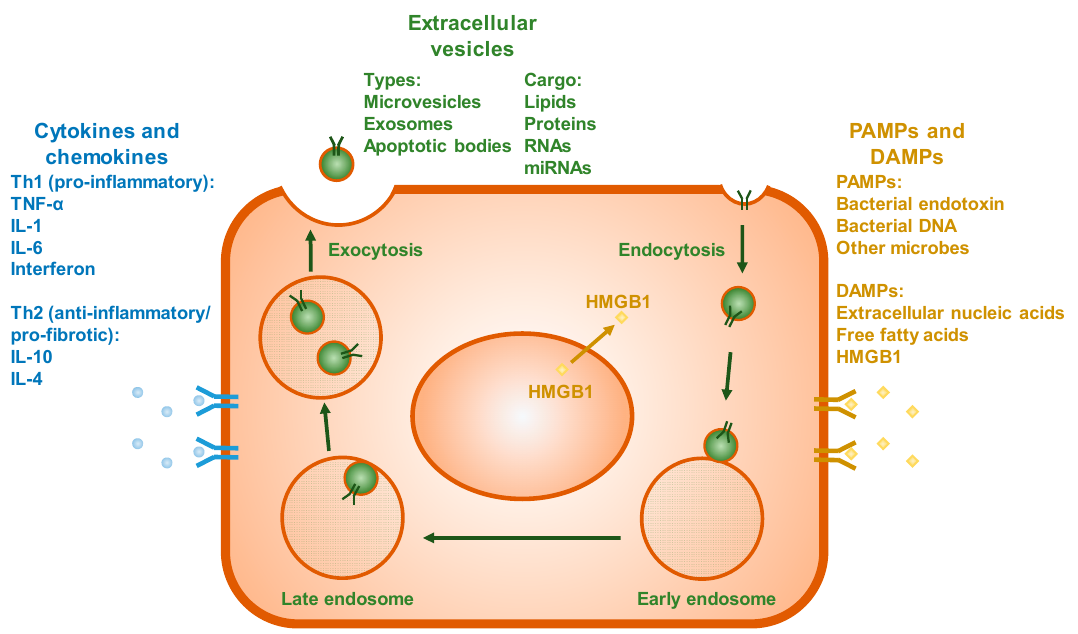
Figure 3. Specific mechanisms of communication in response to stress. Injured cells can release several signals to mediate communication between them and distal tissues. The profiles of both T helper 1 (Th1) (i.e., proinflammatory) and T helper 2 (Th2) (i.e., anti-inflammatory or profibrotic) cytokines is altered during hepatic injury. Additionally, the liver can respond to PAMPs (e.g., bacterial LPS) from other organs, such as the gastrointestinal (GI) tract, and/or respond or release DAMPs (e.g., high motility group box-1 (HMGB1)) that serve as ‘danger signals’ to pattern recognition receptors in other organs. IL: interleukin.